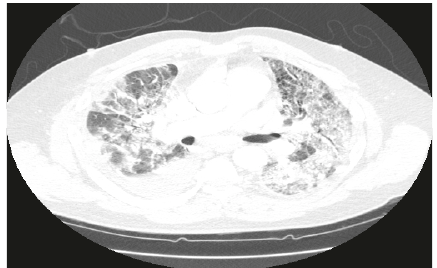
Figure 5: Chest CT angiogram taken during the acute exacerbation. Right pleural fluid filling 1/4 of chest, bilateral interstitial, and airspace disease. Ground glass opacities, pathological adenopathies in the mediastinum, cardiomegaly, and no pulmonary embolus.